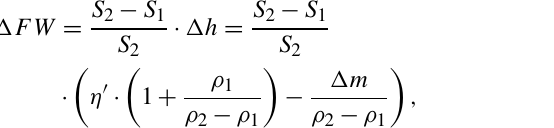
Basin. The thermosteric component slightly compensates for the halosteric